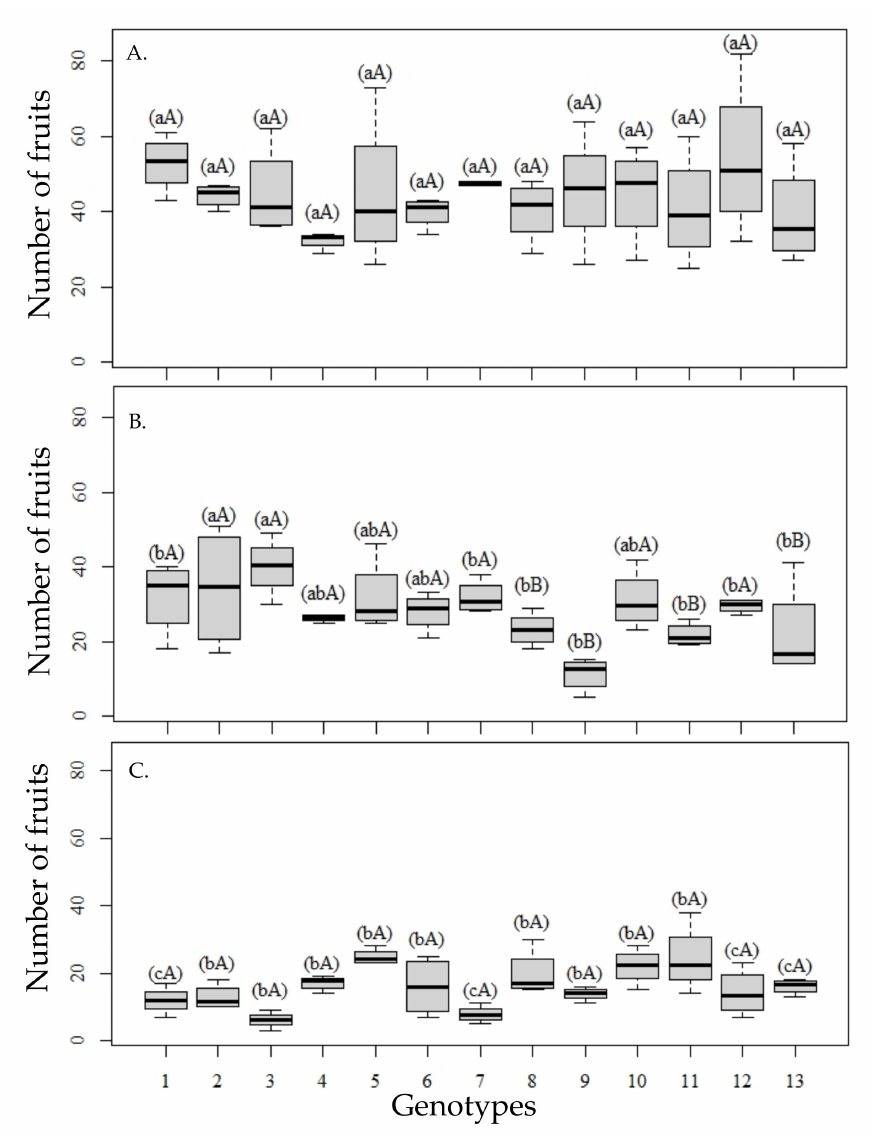
Figure 1. Boxplot relative to the mean number of fruits per plant of 13 citrus rootstocks in combination with ‘Tahiti’ acid lime ( Citrus × latifolia (Yu. Tanaka) Tanaka) irrigated with water of 0.14 ( A ), 2.40 ( B ), and 4.80 dS m − 1 ( C ) in the first year. For identification of genotypes, see Table 1. Boxplots with the same lowercase letter do not differ statistically, according to the Tukey test between salinity levels ( p ≤ 0.05), and those with the same uppercase letter belong to the same genotype group, according to the Scott–Knott test ( p ≤